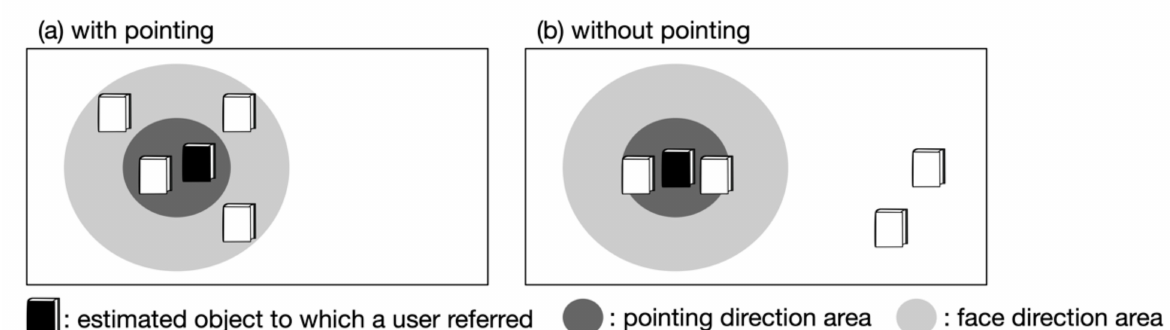
Figure 7. How to decide whether to use a pointing